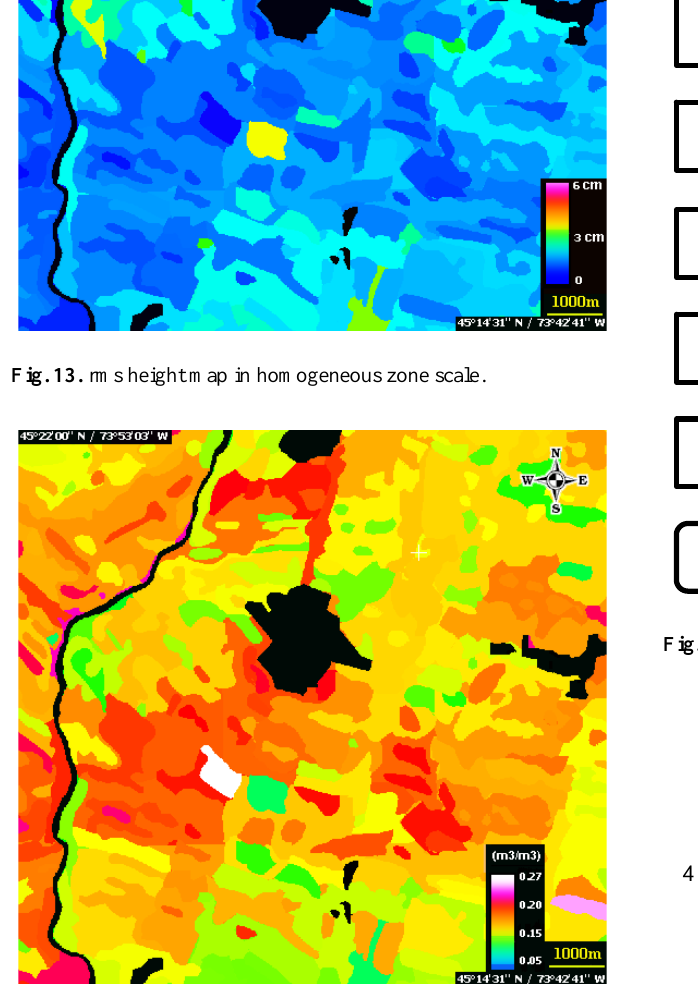
Fig. 14. Volumetric humidity map at homogeneous zone scale. have the lowest error.